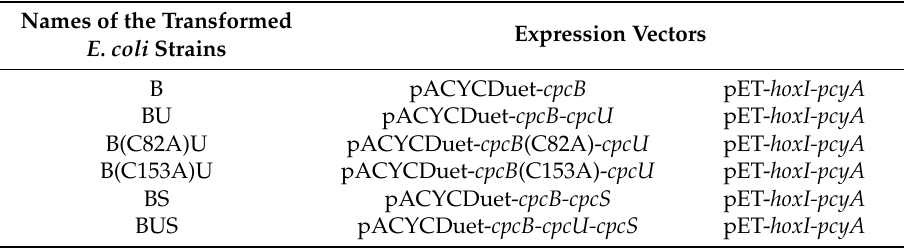
Table 4. Designation of the recombinant